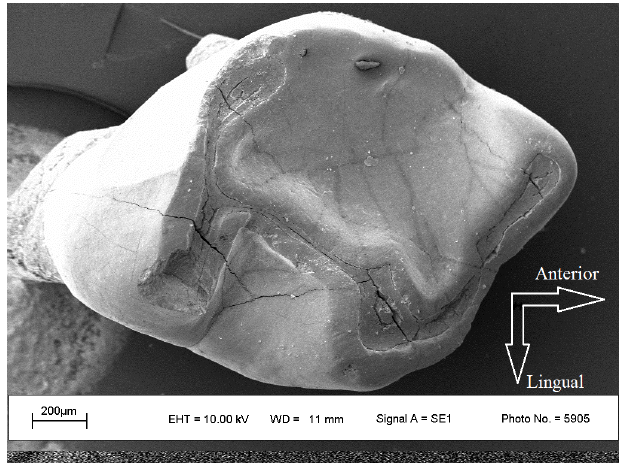
FIGURE 15 : The scanning electron microscope image of first or second lower molar in Spermophilus